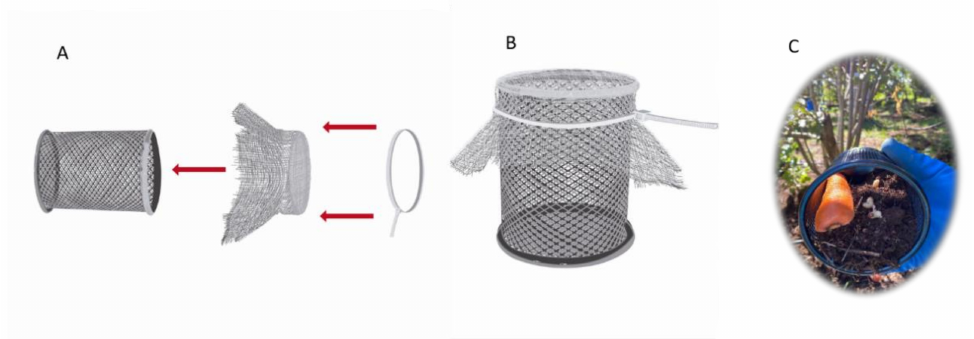
Figure 3. Metallic jar with holes for assays with entomopathogenic nematodes in the greenhouse and the field. ( A ) Schematic sections, ( B ) empty metallic jar sealed at both ends, ( C ) filled with autoclaved soil, host larvae, and a chunk of carrot as a food